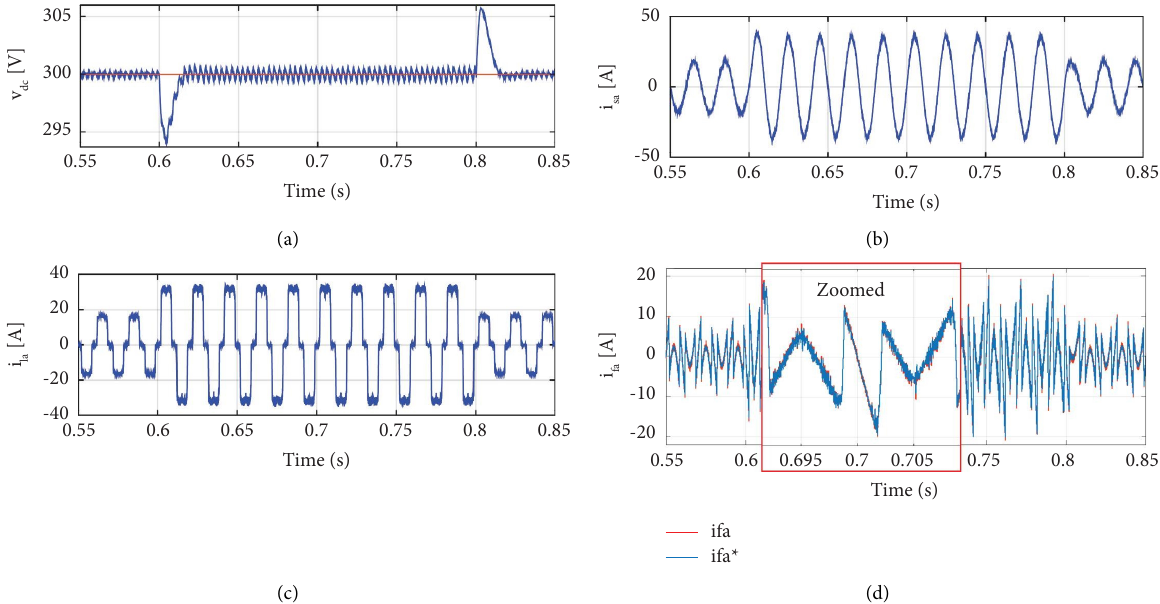
Figure 8: Experimental results for load changes: (a) voltage DC link, (b) source currents, (c) load currents, and (d) SAPF fltering current i and i fa